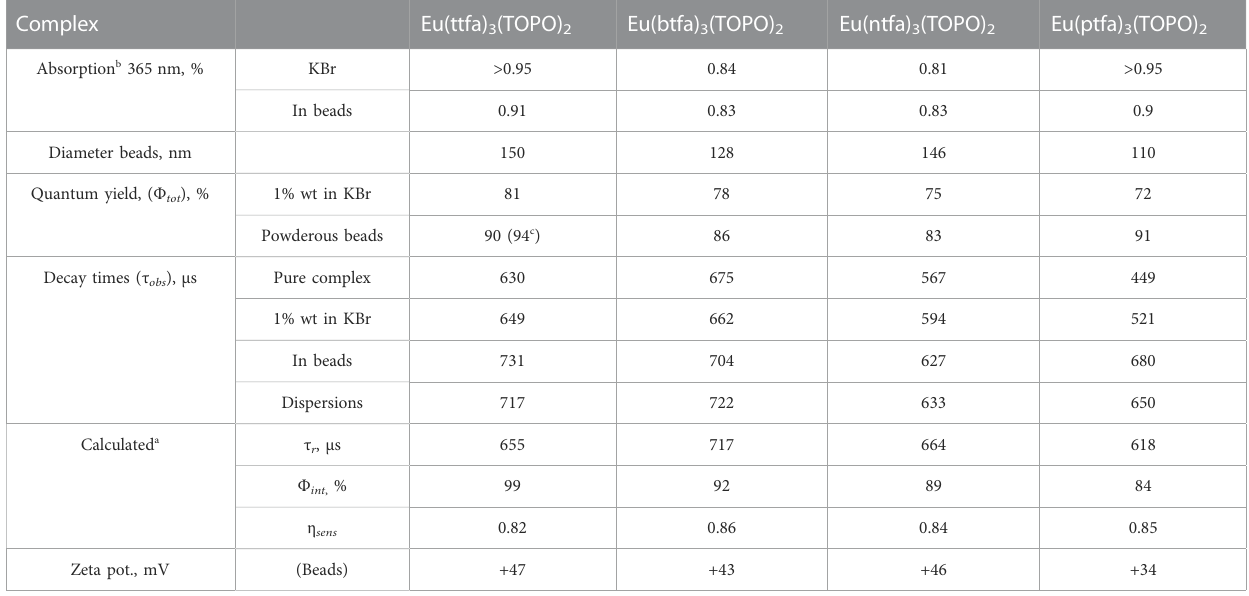
TABLE1Relevantdataforthecomplexesandcorrespondingbeads(beaddatafromsynthesiswith10%wtcomplex; fi nalconcentrationsmaybetakenfromFigure 6) Φ tot = overall (experimental) quantum yields, τ obs = experimental decay times; all experimental data are obtained with 365 nm excitation from powderous samples, except for the beads ’ lifetimes in (aqueous) dispersions. τ r = calculated radiative lifetime, Φ int = intrinsic quantum yields, η sens = sensitization ef fi ciency a